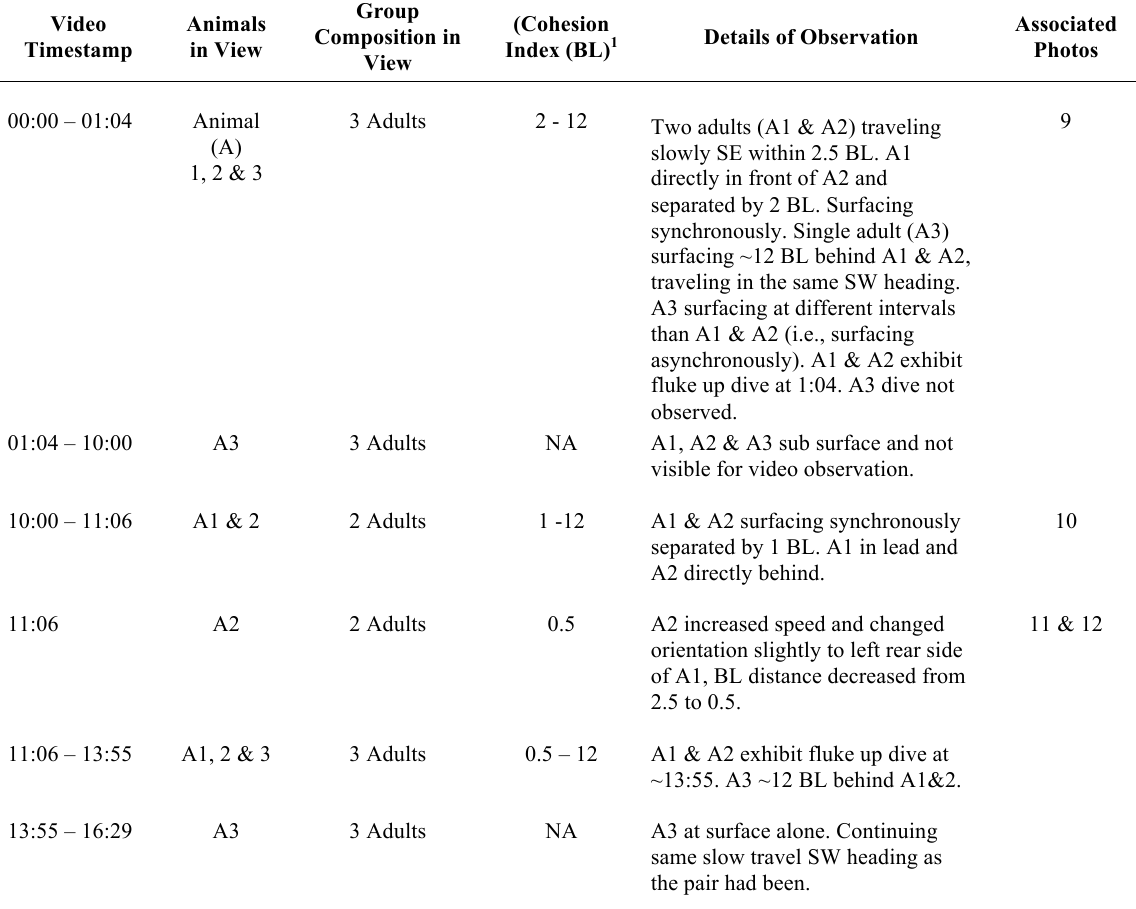
Descriptive Analyses of Blue Whale Group on 29 July